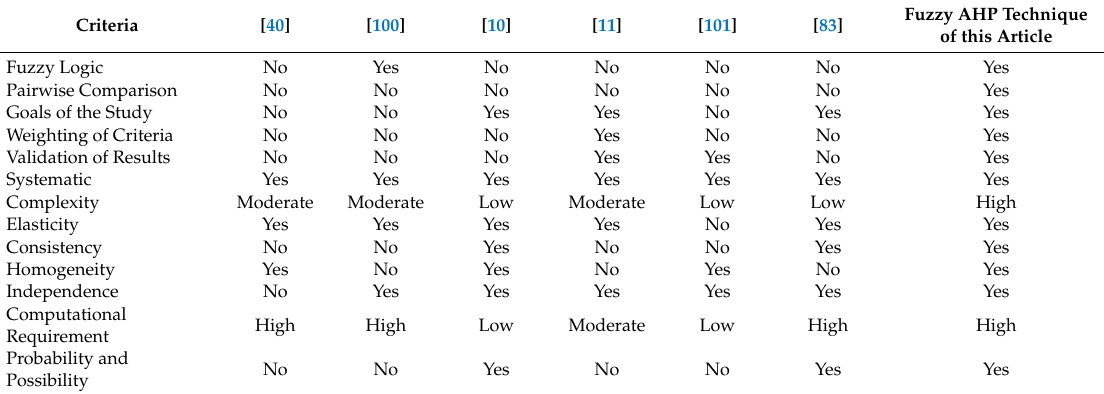
Table 23. Comparison of fuzzy AHP with other methodologies for ISCs selection /